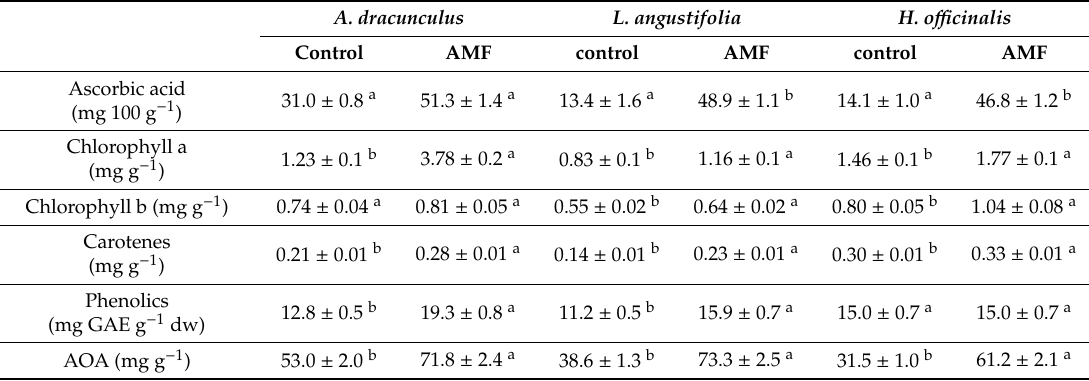
Table 3. E ff ect of AMF inoculation on plant antioxidant compounds and activity of aromatic species subjected to abiotic stress after harvesting.